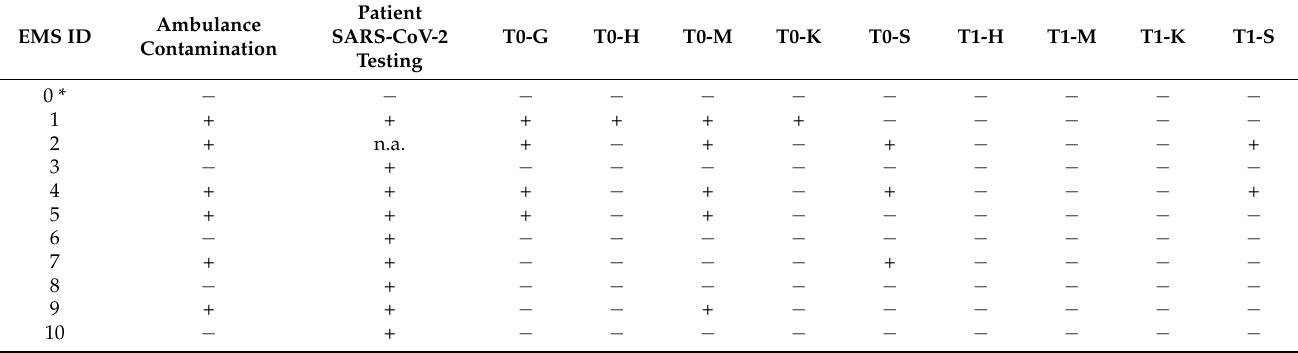
Table 1. SARS-CoV-2 contamination of high-touch surfaces in ambulances. Ambulance contami- nation was present (+) if at least one surface swab tested positive for SARS-CoV-2. The table also reports the results of each patient’s SARS-CoV-2 test (+/ − ) upon hospital admission. Results of the environmental swabs are presented for each sampling site, both pre- (T0) and post- (T1) decontami- nation